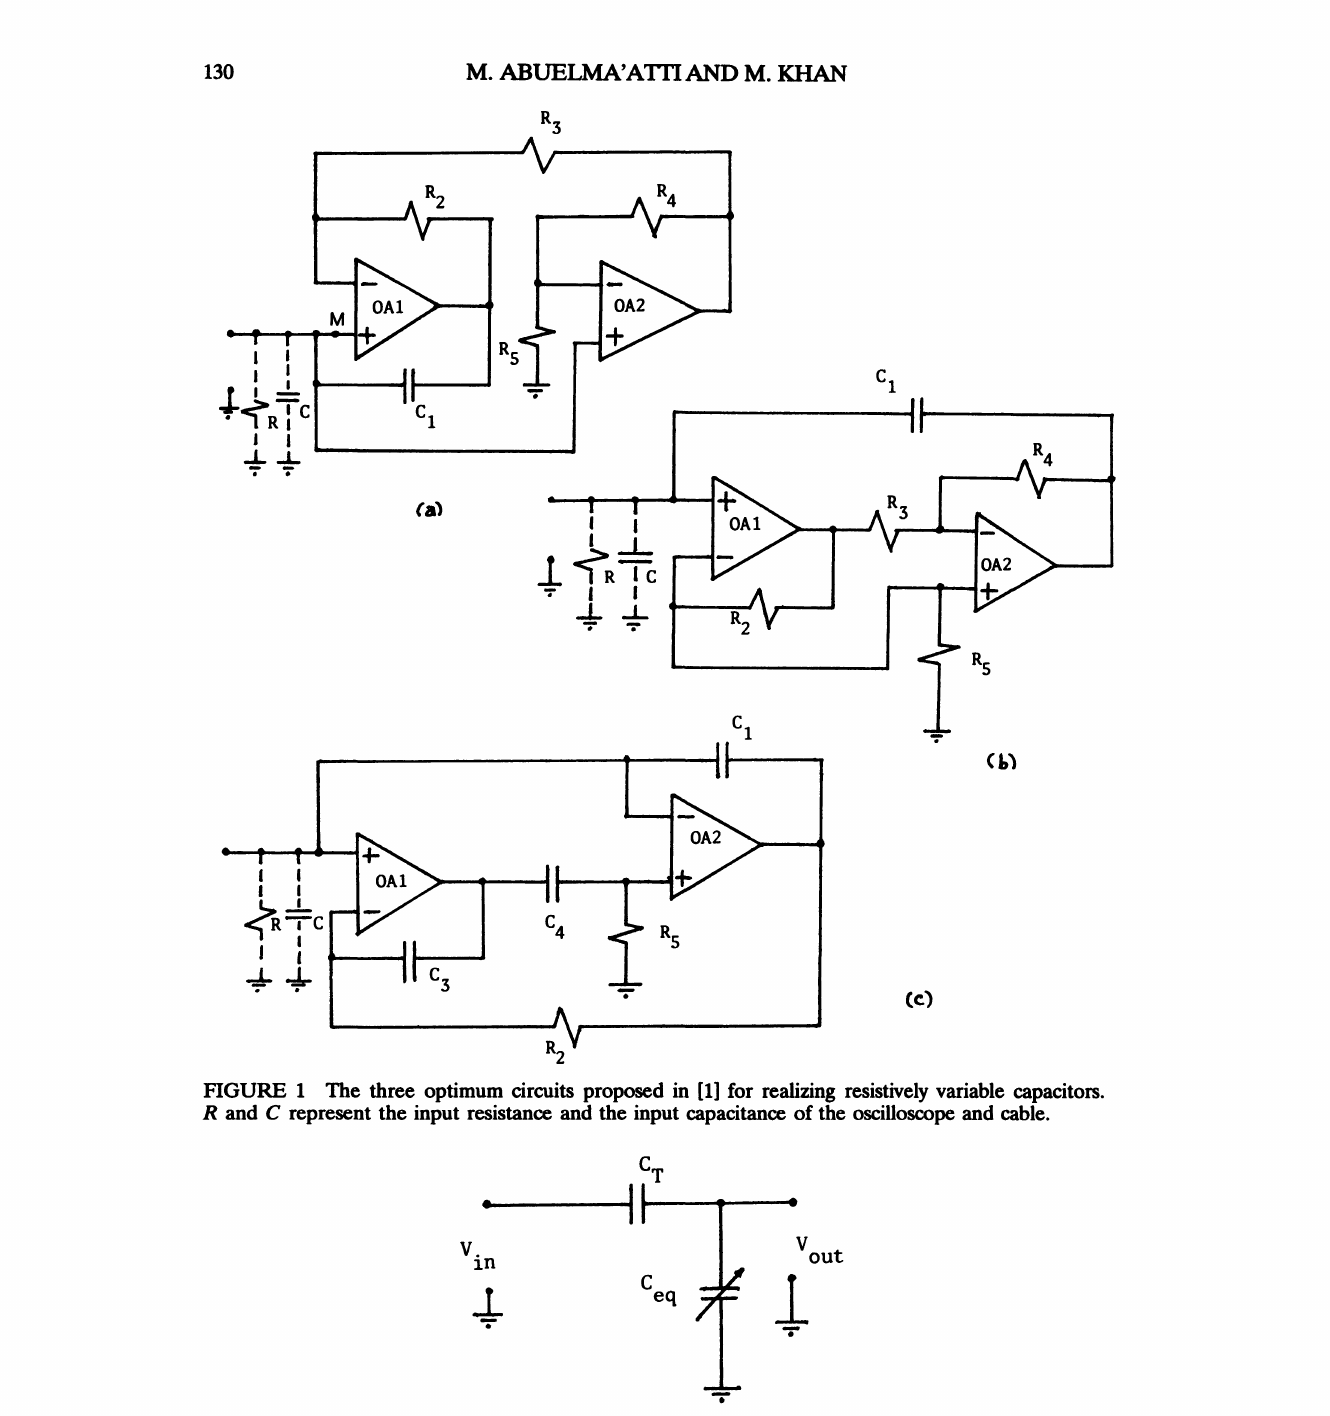
FIGURE 2 Voltage divider circuit used for checking the proposed resistively variable capacitors of Fig.